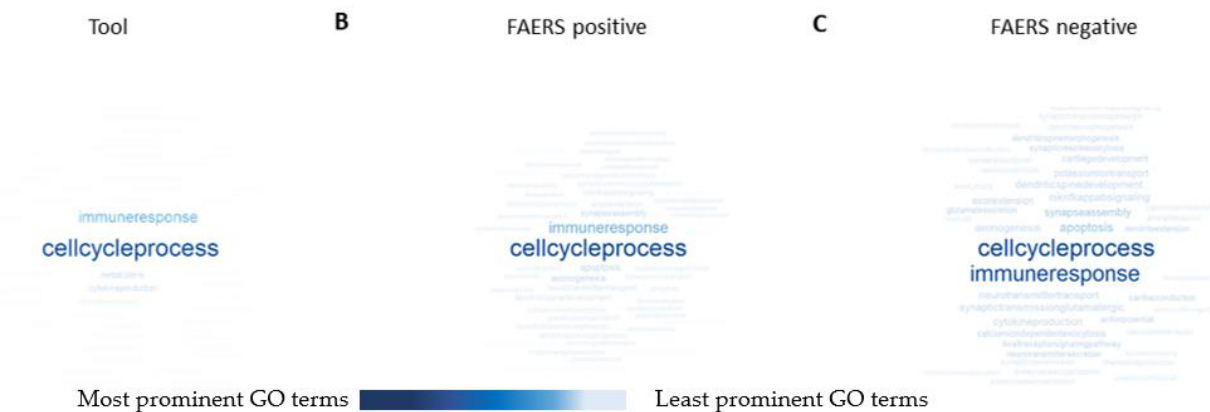
Figure 4. The most prominent gene ontology (GO) terms of the ( A ) tool, ( B ) FAERS-positive, and ( C ) FAERS-negative compounds in a word cloud. The most frequent GO terms have the largest font size and the darkest blue color. In all the compound categories, “cell cycle process” was the most common GO term. In FAERS-positive and FAERS-negative categories, “apoptosis” was also prominent. See Supplementary File S2.